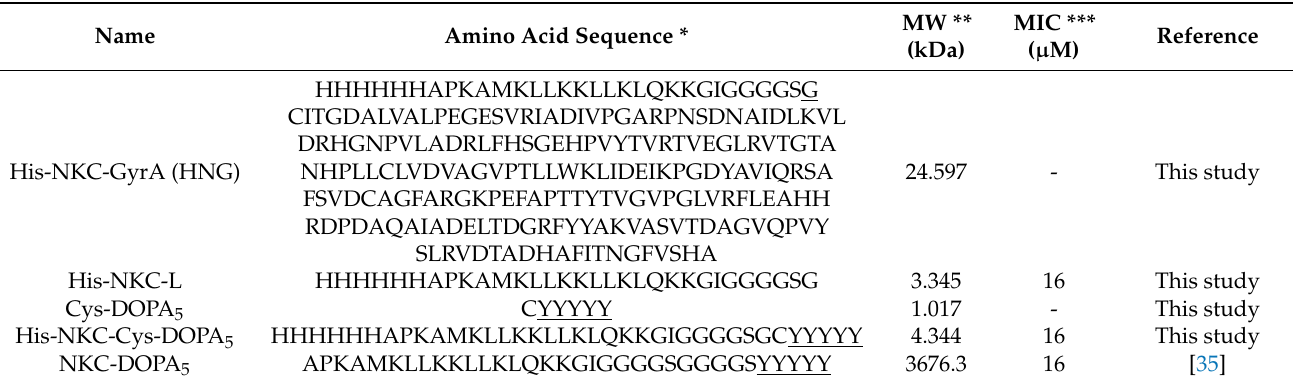
Table 1. Recombinant protein and synthetic peptides used in this study.